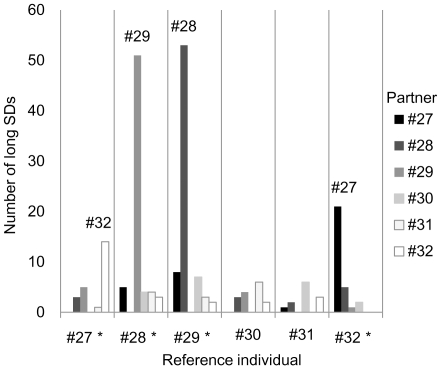
Distribution of synchronous dive (SD) durations.The figures in the upper left of each graph indicate the reference individual ID number. The points with a time lag of 0 show the SD duration as calculated from the original data of the reference individual and those of the partners. The points with a time lag of −10 s to −1 s and 1 s to 10 s show the SD duration as calculated from the original data of the reference individual and the time-shifted data of the partners, which was the original data staggered from −10 s to 10 s, respectively.